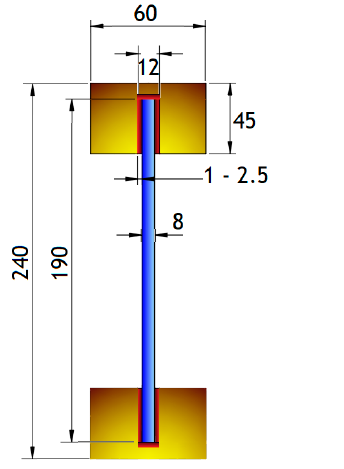
Figure 7. Cross section of the compared beams—TGIB-gf [10,18].